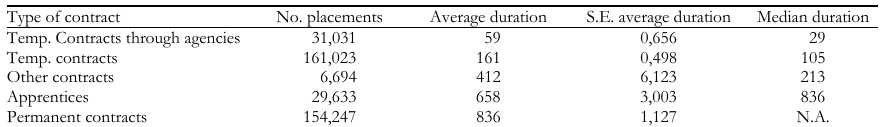
Summarised survival curve